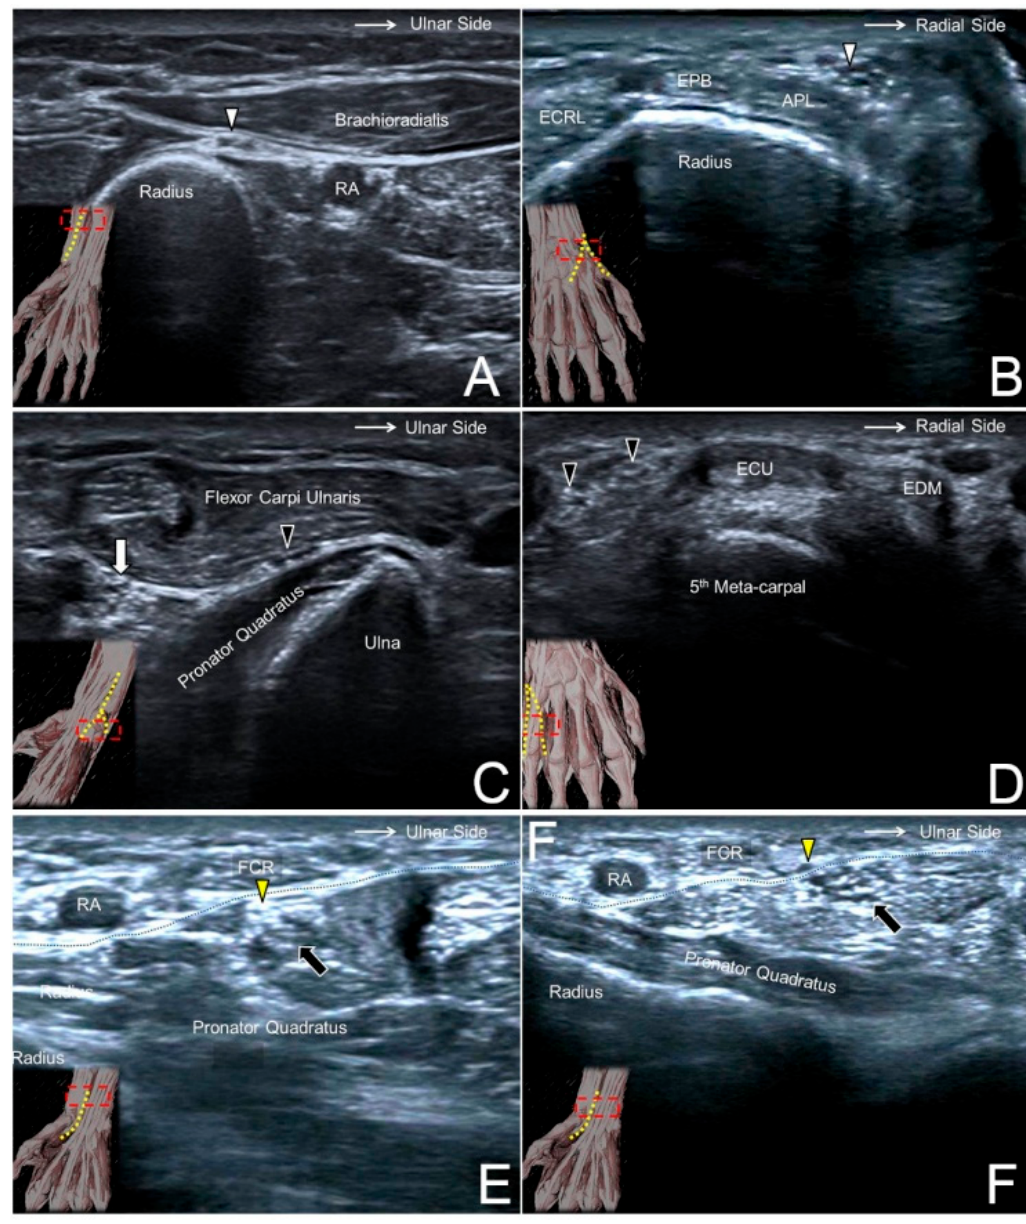
Figure 7. The superficial radial nerve (white arrowhead) at the level of the distal forearm (A) and the radial dorsal wrist (B) . The dorsal ulnar cutaneous nerve (black arrowhead) at the level of the distal forearm (C) and the ulnar side of the dorsal wrist (D) . The palmar branch of the median nerve (yellow arrowhead) at the level of the distal forearm (E) and emerging from the antebrachial fascia (black dashed line) (F) . RA, radial artery; ECRL, extensor carpi radialis longus muscle; APL, abductor pollicis longus tendon; EPB, extensor pollicis brevis tendon; white arrow, ulnar nerve; black arrow, median nerve.